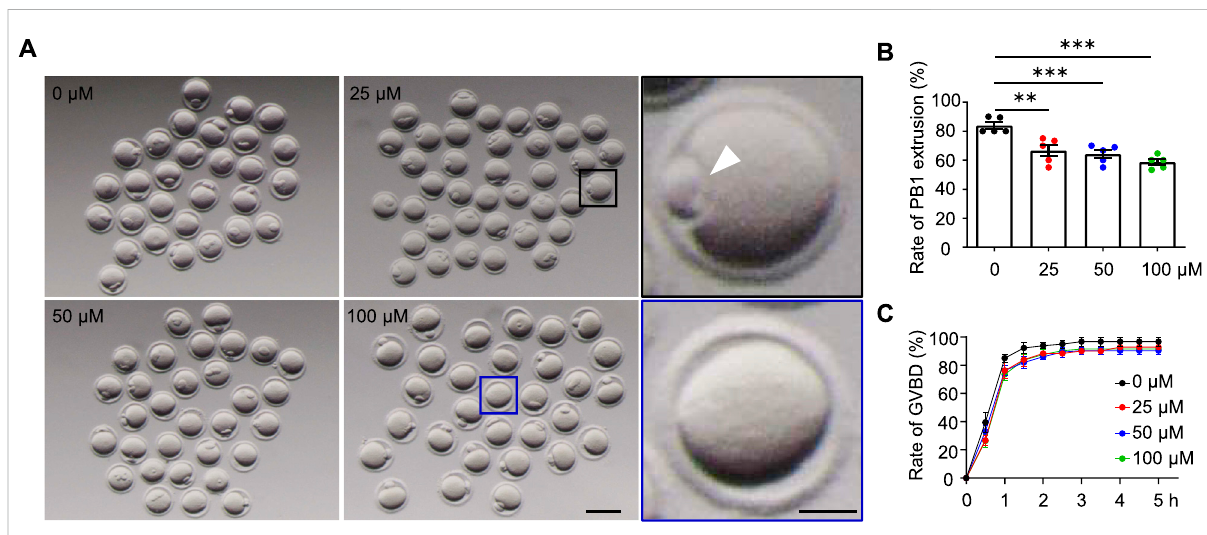
FIGURE 2 AAIexposuredisruptsthe fi rstpolarbody(PB1)extrusioninmouseoocytes. (A) TheGVoocyteswerematuredintheM16mediumwith0,25,50, and100 μ MAAI for12 hto reach theMII stage. Representative images showing PB1extrusion.Scalebar, 100 μ m.Black boxand theenlarged picture showing an oocyte with PB1 (PB1, white arrowhead). Blue box and the enlarged picture showing an oocyte without PB1. Scale bar in the enlarged picture, 25 μ m. (B) The quanti fi cation of PB1 extrusion rate in (A) . Error bar, mean ± SEM of 5 independent experiments. ~20 GV oocytes per treatment in each experiment and totally, 104, 105, 94, and 92 GV oocytes for 0, 25, 50, and 100 μ M AAI treatments, respectively. Only comparisons with signi fi cant differences were indicated; **, p < 0.01; ***, p < 0.001; one-way ANOVA and the LSD test. (C) After GV oocytes were matured in the M16mediumwith0,25,50,and50 μ MAAIfortheindicatedtime,GVBDrateswerecalculated.Errorbar,mean±SEMof3independentexperiments. GVBD rates seemed to be slightly decreased in AAI treatment groups compared with the control but no signi fi cant difference was detected. ~20 GV oocytes per treatment in each experiment. Totally, 70, 70, 69, and 69 GV oocytes for 0, 25, 50, and 100 μ M AAI treatments,